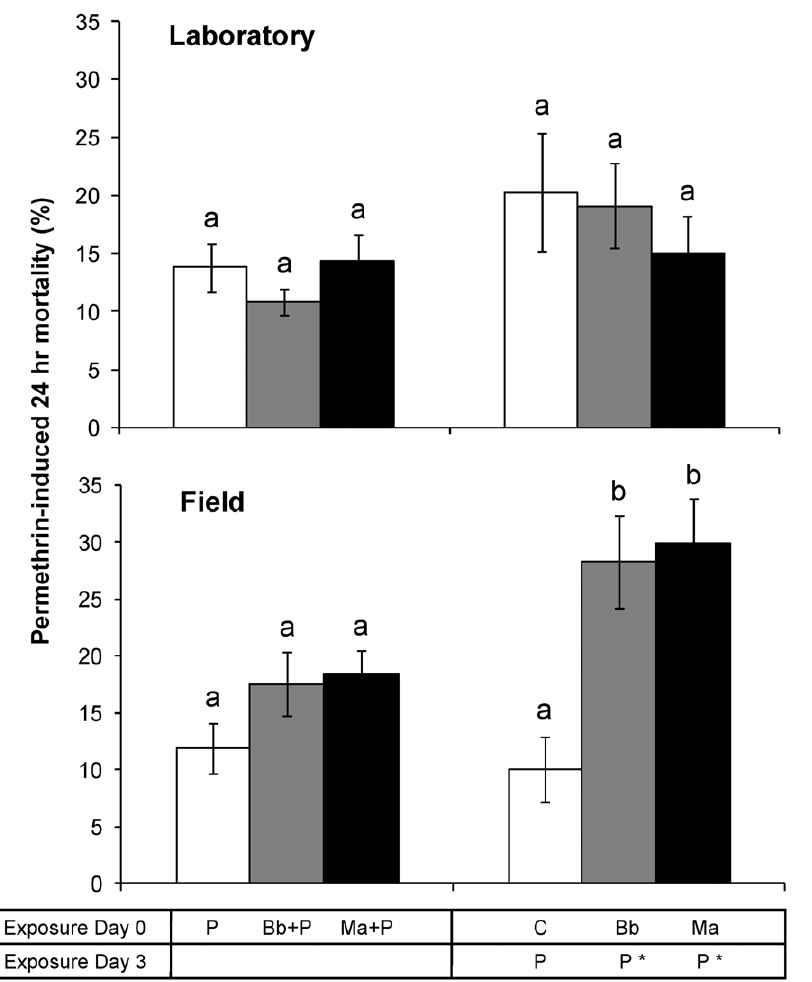
Figure 3. Effect of fungus on permethrin sensitivity. Mean ( 6 SEM) percentage permethrin-induced mortality of uninfected (white), Beauveria - infected (grey) and Metarhizium -infected (black) mosquitoes from the laboratory colony (top) and field An. gambiae s.s population (bottom). Data show mortality rates measured 24 hrs after permethrin exposure on day 0 (left) and day 3 (right), from ten laboratory and eight field replicates of 28 females per group. Mortality rates of fungus-infected groups exposed to permethrin on day 3 (*) were corrected for mortality of corresponding fungus-infected groups exposed to control papers. Significant differences are indicated by non-corresponding letters.